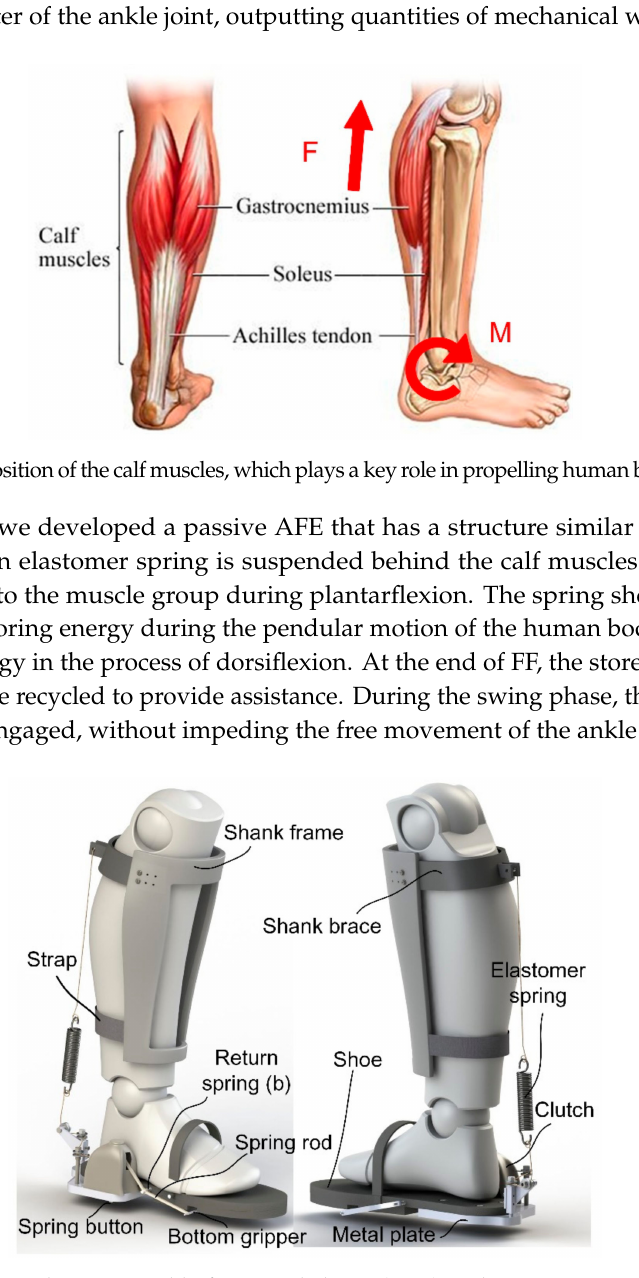
Figure 3. The proposed passive ankle-foot exoskeleton (AFE) and its components. The core and fundamental part is the clever clutch that ensures the implementation of the